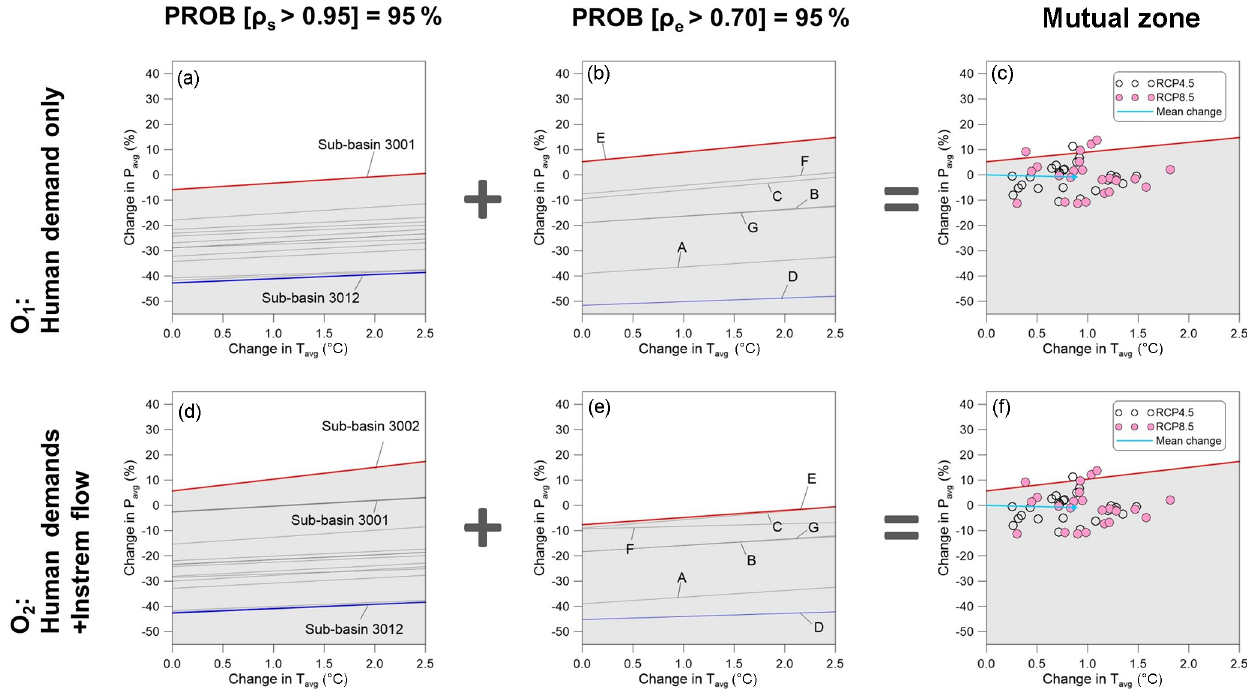
Figure 9. Climatic bounds for π s95 = 95% (a, d) and π e70 = 95% (b, e) , and the bound mutually satisfying both criteria (c, f) under the human-demand-only operations (a–c) in comparison to the operations considering the instream flows at the location E (d–f ). The empty and filled circles are the 50 GCM projections for